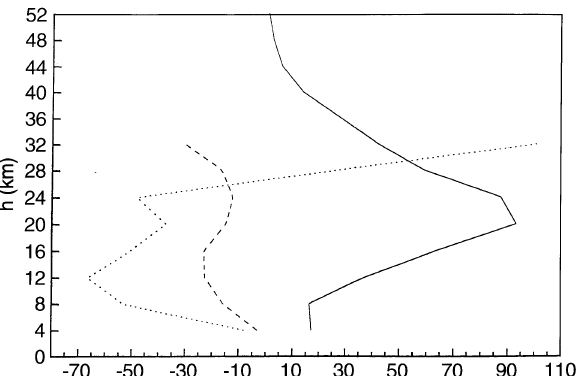
Fig. 7. 6 March 1993; solid line : O (cid:51) profile (10 (cid:49)(cid:49) moleculescm (cid:126)(cid:51) ); dashed line : zonal velocity profile (0.5 ms (cid:126)(cid:49) ); dotted line : meridional velocity profile (0.5 ms (cid:126)(cid:49) )